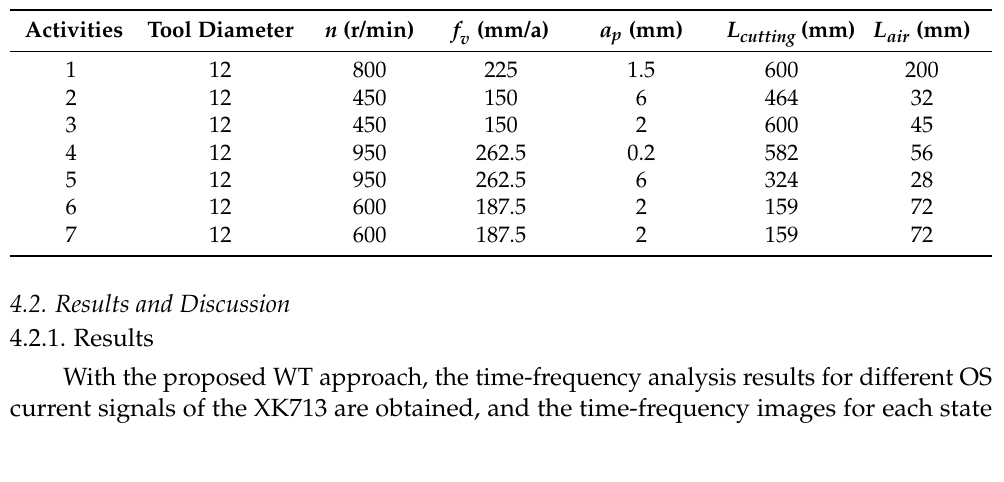
Figure 7. Equipment used at the experimental site. Table 1. Main parameters of cutting